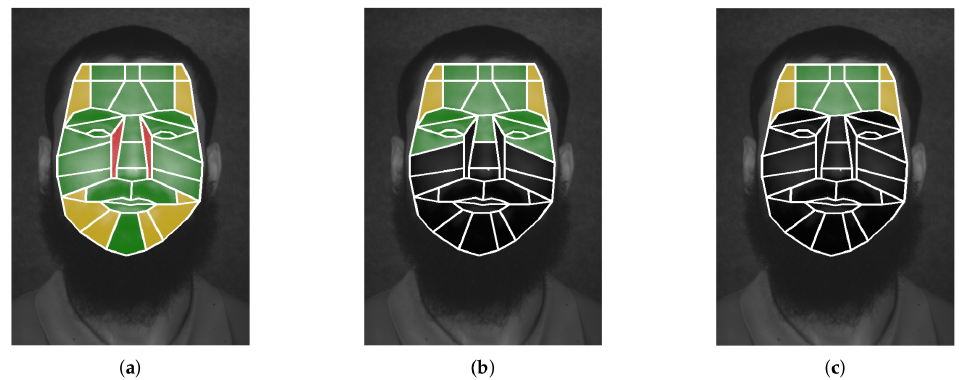
Figure 4. Quality of spectral information related to each facial ROI according to the visible parts. ( a ) Facial ROI no mask. ( b ) Facial ROI with mask/scarf. ( c ) Facial ROI with sunglasses and